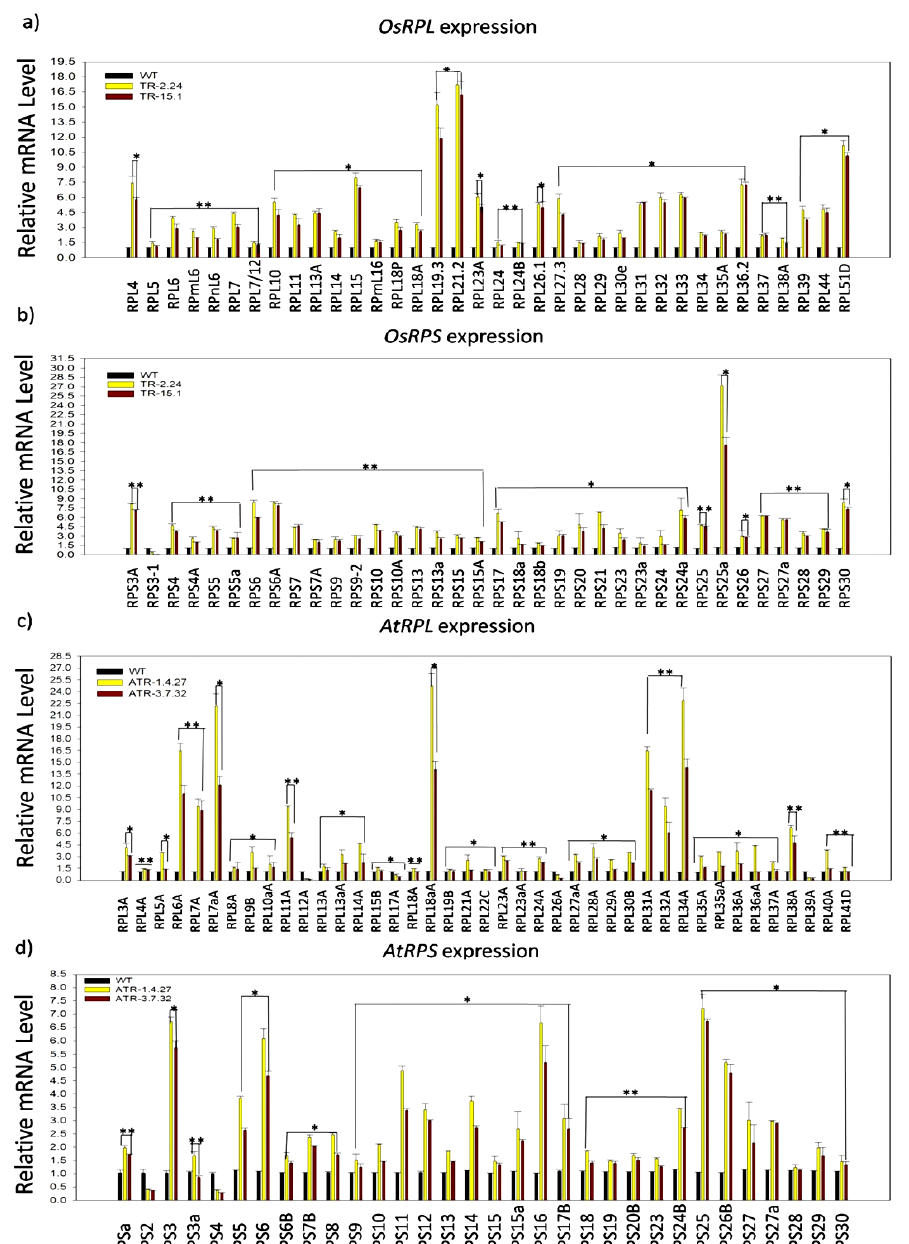
Figure 2. Transcriptional regulation of ribosomal protein large subunit ( RPL ) and small subunit ( RPS ) genes in the TOR -OE lines of rice and Arabidopsis. The 7 DAG plants of two high AtTOR -expressing rice transgenic lines TR-2.24 and TR-15.1 were used to analyze the expression of RPL and RPS genes. The WT plants were used as controls. ( a ) Expression analysis of rice RPL genes in two high AtTOR overexpression lines of rice, TR-2.24 and TR-15.1. The RPL4 , RPL14 , RPL18A , RPL19.3 , RPL36.2 and RPL51 genes were highly upregulated by 20-fold in both of the transgenic lines. ( b ) Expression analysis of rice RPS genes in two transgenic lines. The significant upregulation of RPS gene transcripts in two transgenic lines was observed, where the RPS3A , RPS6 , RPS6A , RPS25A and RPS30 genes were highly upregulated by more than 7-fold in the transgenic plants. ( c , d ) The expression of RPL and RPS genes was also analyzed in two TOR -OE transgenic lines, ATR-1.4.27 and ATR-3.7.32, of Arabidopsis. The fold change was normalized using the ∆∆ CT method relative to the WT plants. Rice Actin ( Act1 ) and Arabidopsis Actin ( Act2 ) were used as internal controls. Three biological and three technical replicates were included in this study. Vertical bars indicate the mean ± SE of three independent experiments and ANOVA analysis indicated the statistically significant differences, represented by asterisks (*) p < 0.05 and (**) p <